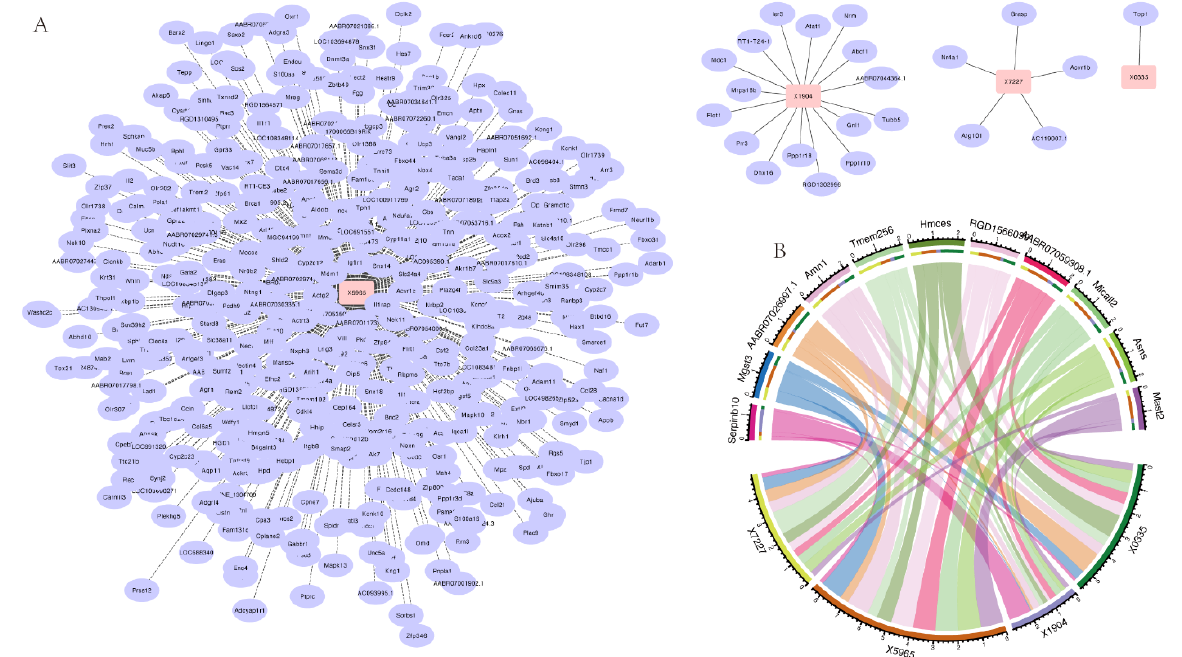
Figure 5. Correlation analysis between selected four lncRNAs and differentially expressed genes. ( A ) The predicted target genes (purple) of lncRNAs (pink) based on positional relationship (cis) and expression correlation (trans) with protein-coding genes. Solid lines represent cis-regulation and dashed lines represent trans-regulation. ( B ) Correlation between four lncRNAs and DEGs. The thickness of the bands show the degree of correlation between the genes.